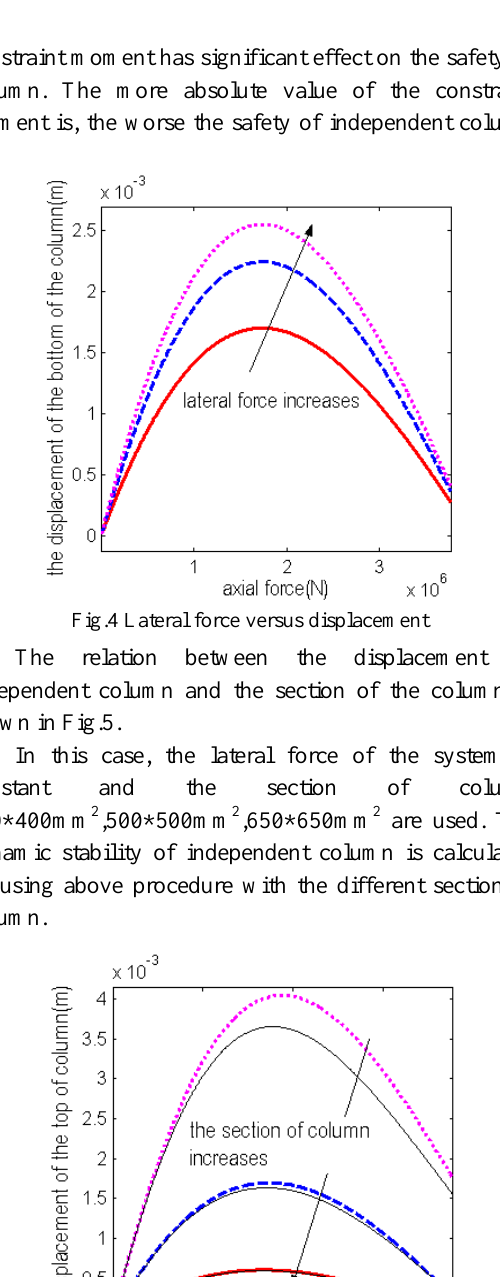
Fig.5 relation between column Section and displacement From the Fig.5, the displacement of the column decreases as the section of column increases.